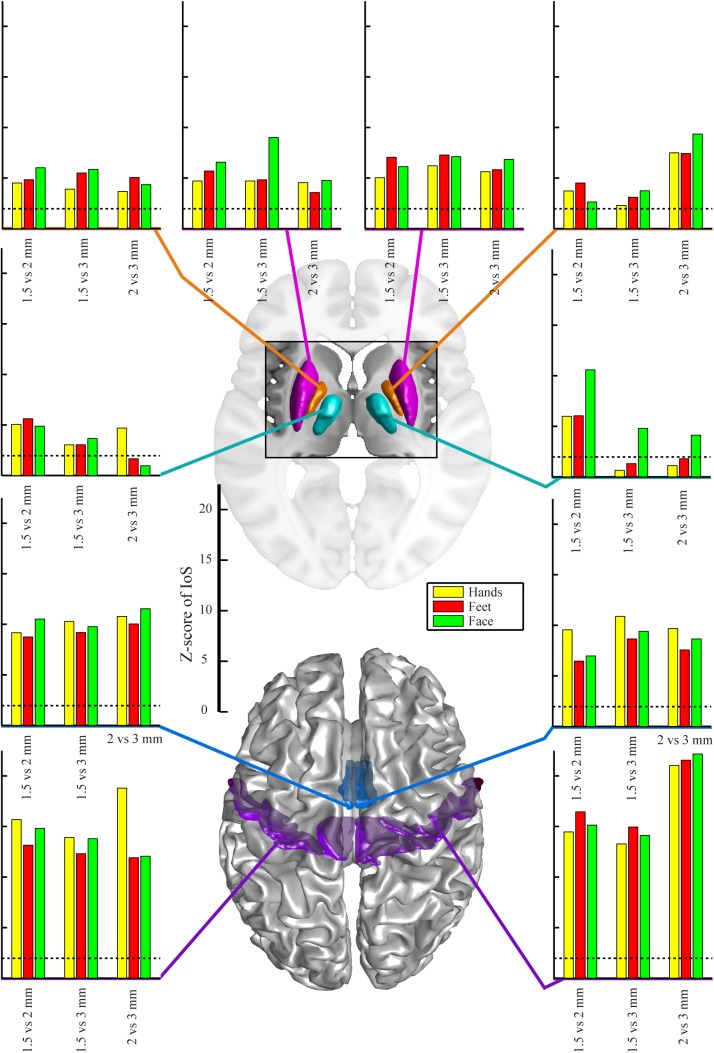
Z-scores of IoS pair-wise comparison for 1.5 mm, 2 mm and 3 mm resolution for different body parts – hands, feet, face and regions-of-interest, projected on canonical anatomical image in standard space. Regions-of-interest in putamen (magenta), pallidum (orange), motor nuclei of the thalamus (cyan), SMA (mid-tone blue) and M1 (violet). Dotted lines indicate significance of correlation (p < 0.05 uncorrected for multiple comparisons, bilateral test).